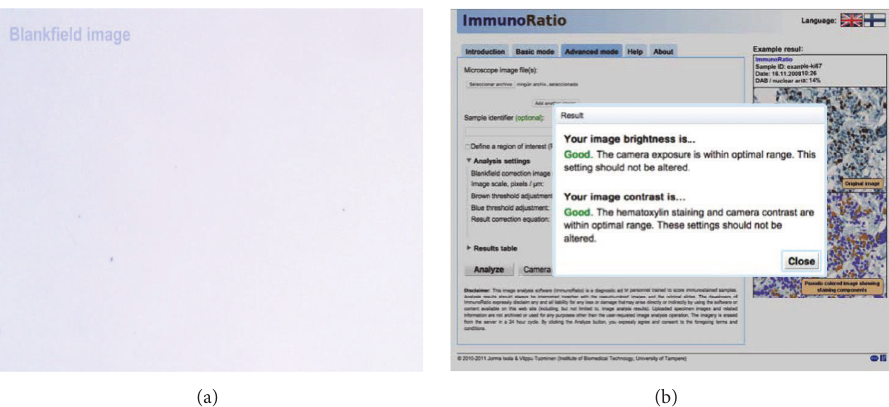
Figure 3: The blank field image used to evaluate the photomicrographs of each ameloblastoma case. (a) The blank field image from a microscope with a digital camera (MOTIC BA-210 and MOTICAM 5.0). (b) The blank field brightness and contrast test indicating the brightness and contrast quality. This procedure is highly recommended for the advanced ImmunoRatio methods (IRA scoring and IRpA scoring). The test was conducted at the following web address: http://153.1.200.58:8080/immunoratio/.